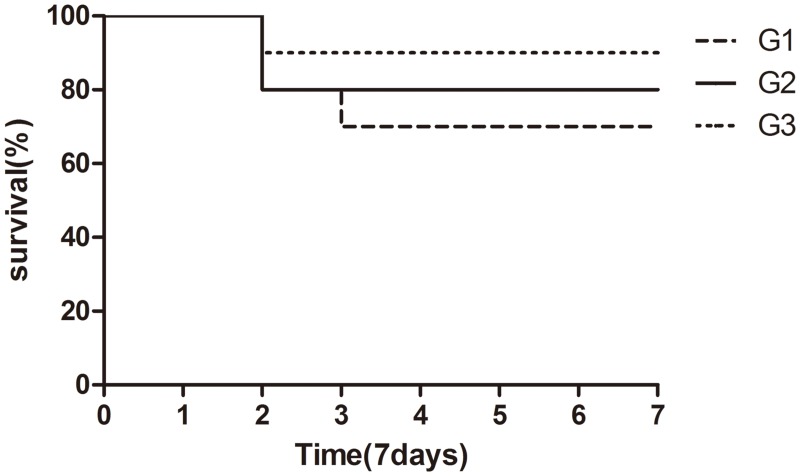
The 7-day survival rate after liver transplantation.Mice were observed for 7 days postoperatively. There were 10 animals in each group. The 7-day survival rate in each group was 90% (G3), 80% (G2), and 70% (G1) according to the Kaplan-Meier test (P>0.05).